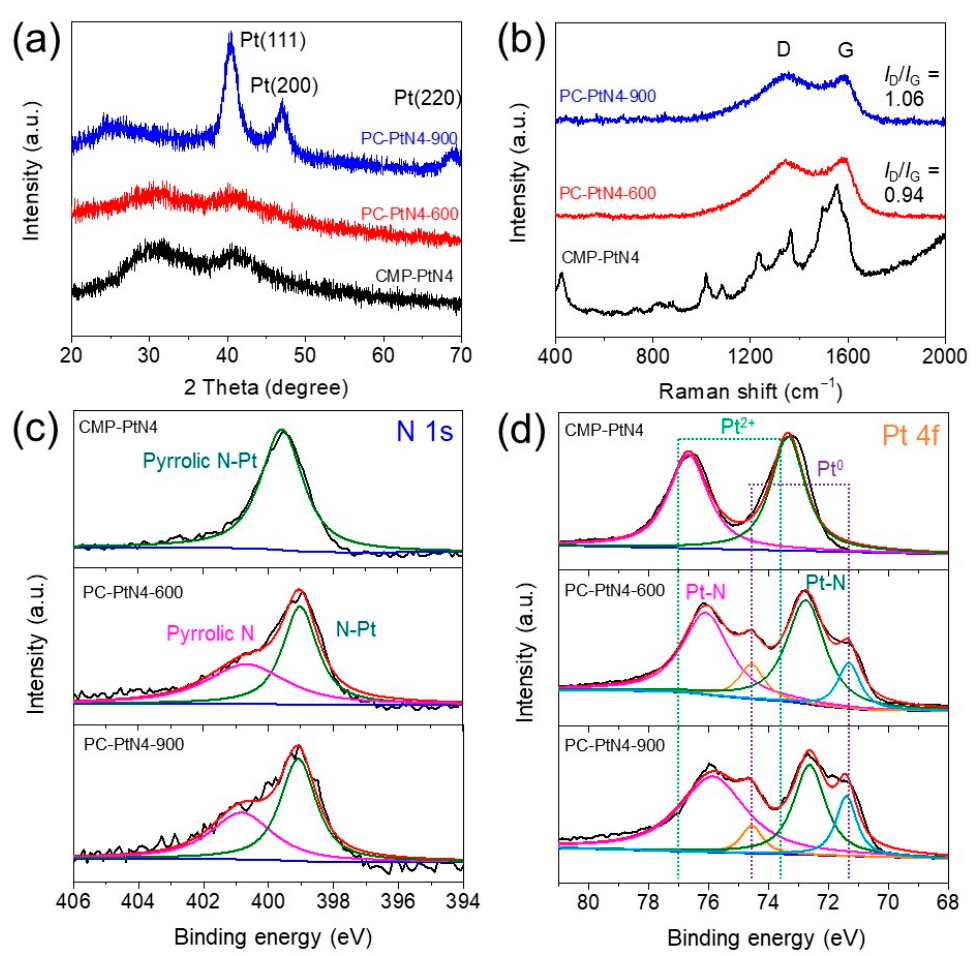
Figure 3. ( a ) X-ray di ff raction (XRD) patterns, ( b ) Raman spectra, ( c ) N 1s X-ray photoemission Figure 3 . ( a ) X-ray diffraction (XRD) patterns, ( b ) Raman spectra, ( c ) N 1s X-ray photoemission spectroscopy (XPS) spectra and ( d ) Pt 4f XPS spectra of spectroscopy (XPS) spectra and ( d ) Pt 4f XPS spectra of PC-PtN4-T.